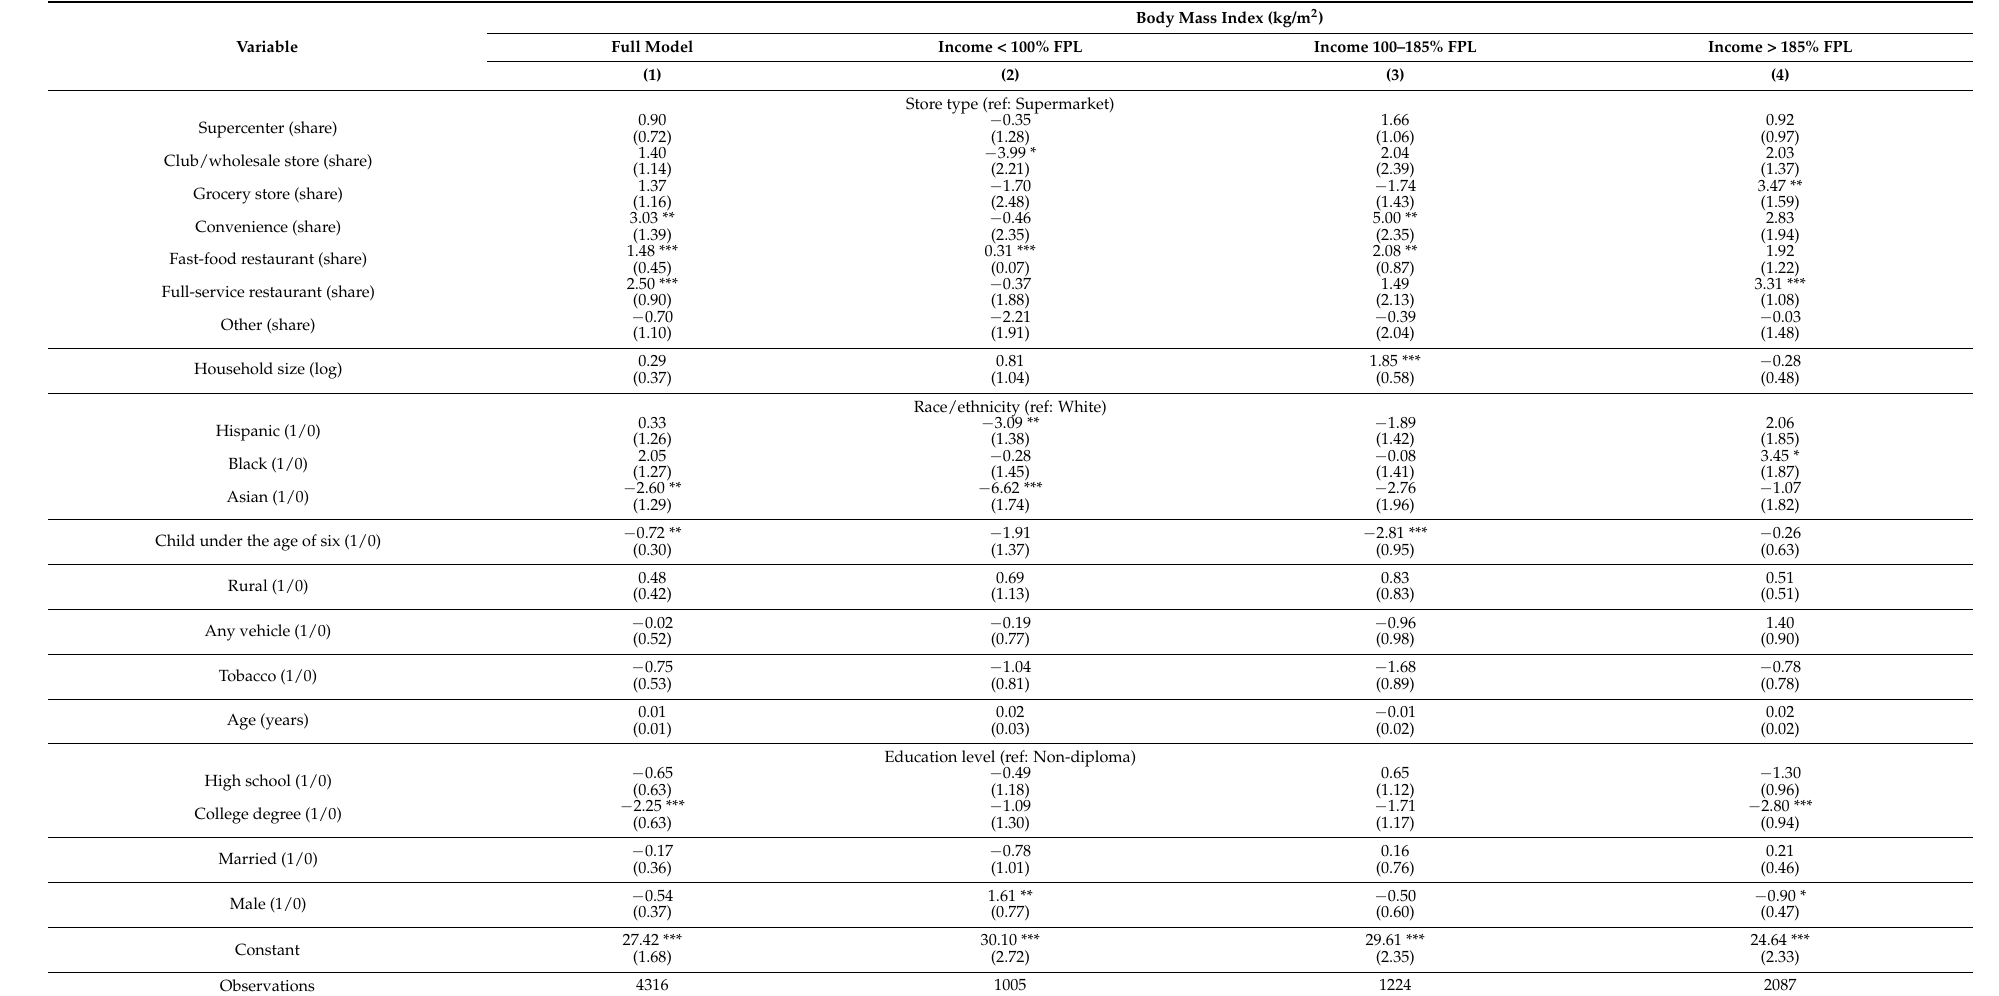
Table 4. Association between body mass index and food outlet types by